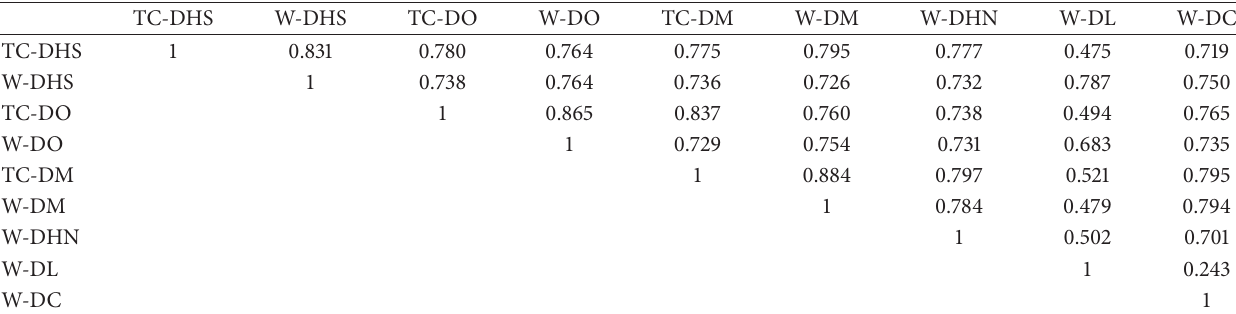
Table 4: The correlation coefficients of the nine Dendrobium samples.